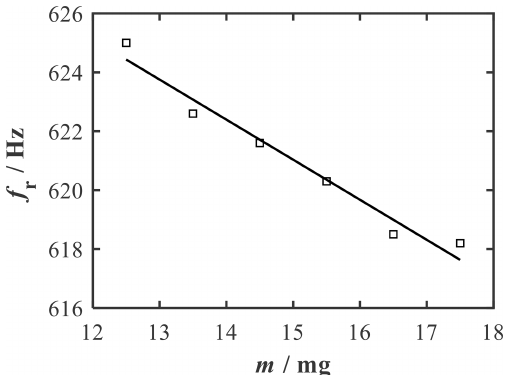
Figure 11. Resonant frequency depending on the sample mass from optical measurement of the three-layer chip. A sensitivity of − 1 . 36Hzmg − 1 can be obtained from the regression line.